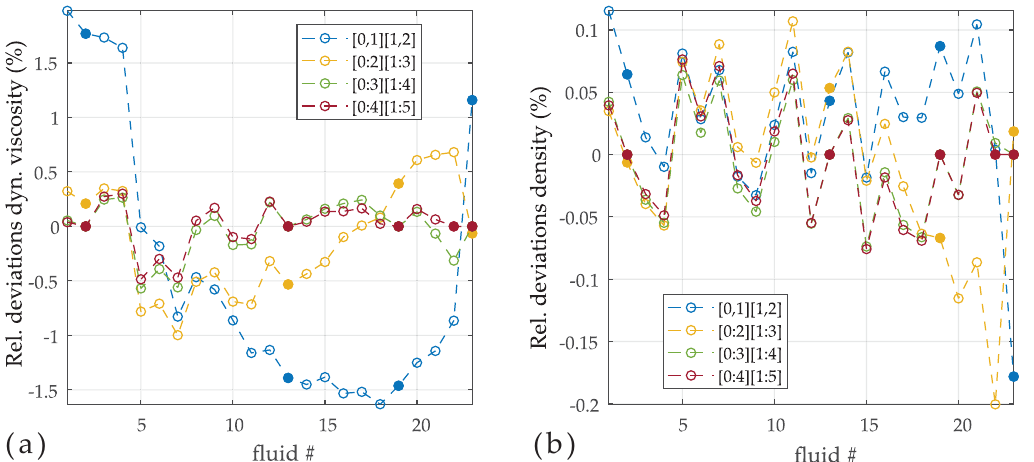
Figure 5. ( a ) Relative deviations of dynamic viscosity η for different polynomial orders. The filled dots were used for calibrating the model constants. Fluid #22 was added for calibrating the highest order [0:4][1:5]. ( b ) Relative deviations for density ρ . Although for viscosity relative deviations were reduced using higher orders, the effect on density is less pronounced.